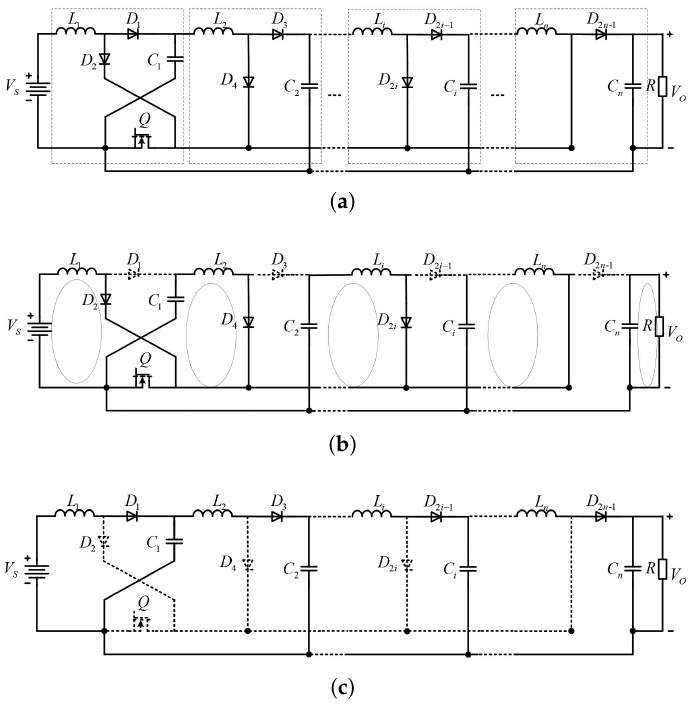
Figure 2. The structure and operational model of the SS-NS-ZN-HGBC: ( a ) the structure of the SS-NS-ZN-HGBC; ( b ) stage I; ( c ) stage